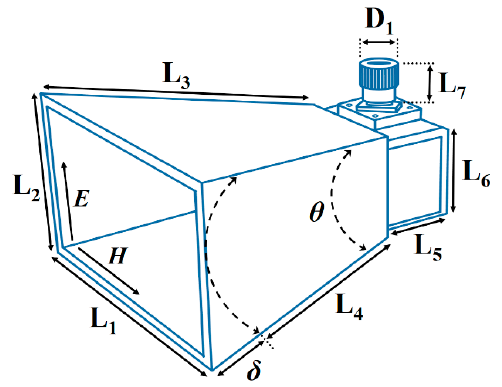
Figure 1. Configuration of the transmitting waveguide antenna. L 1 = 95, L 2 = 78, L 3 = 76, L 5 = 33, L 6 = 15, L 7 = 10, D 1 = 3.4 (all are in mm). L = 15, L = 10, D = 3.4 (all are in 6 7 1